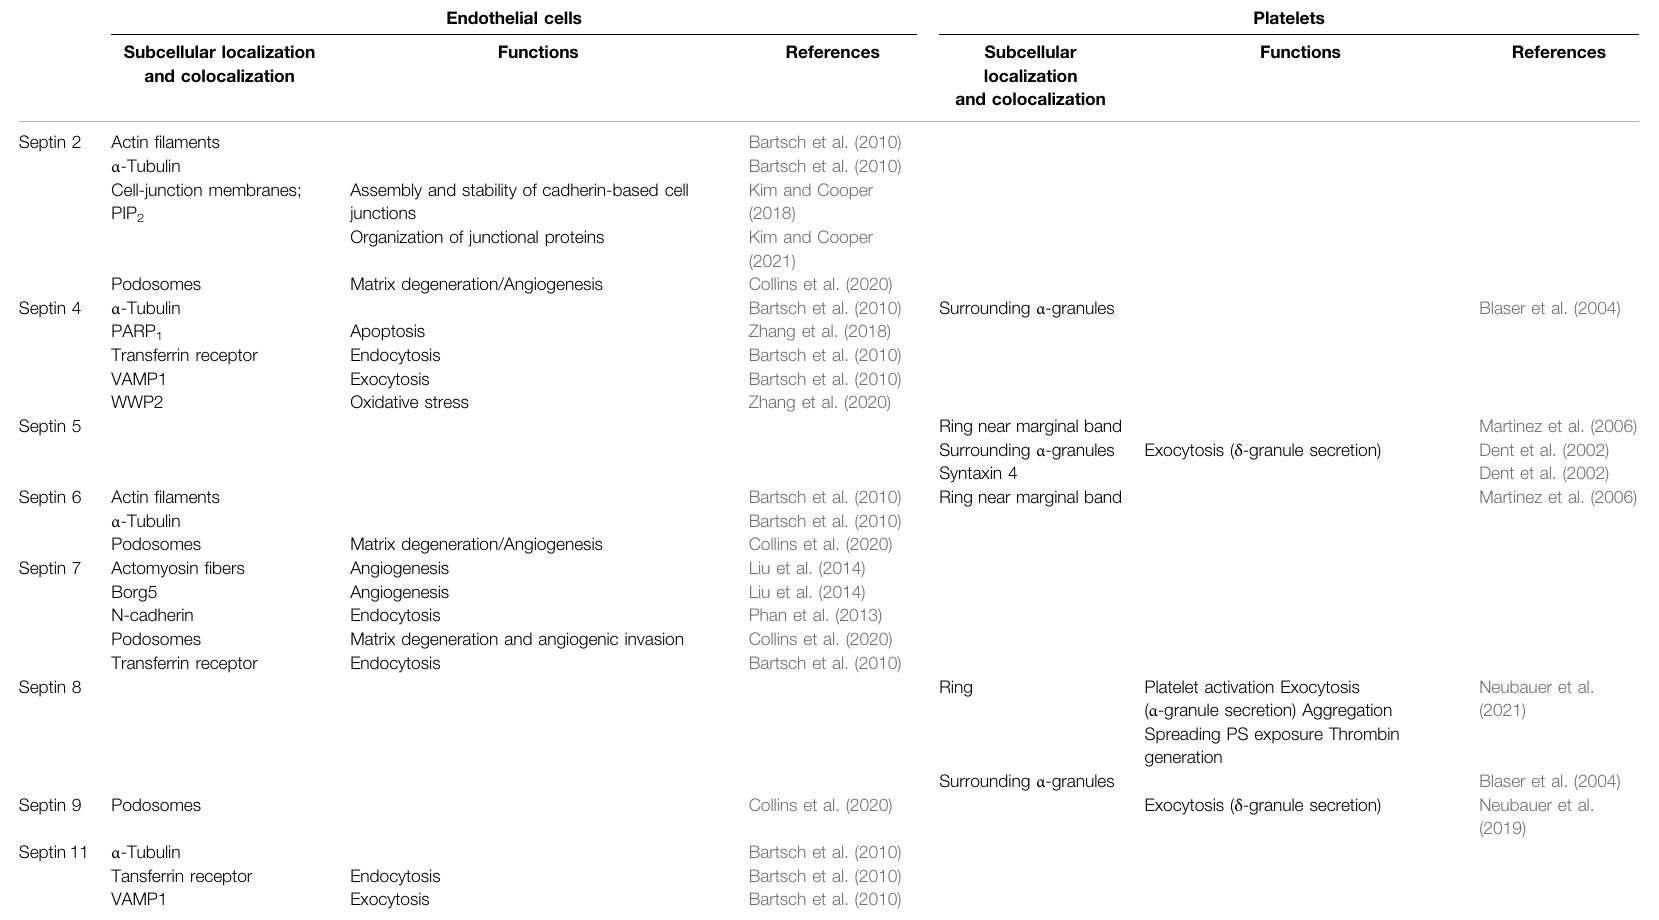
TABLE 1 | Summary table of known septin localization and functions in endothelial cells and